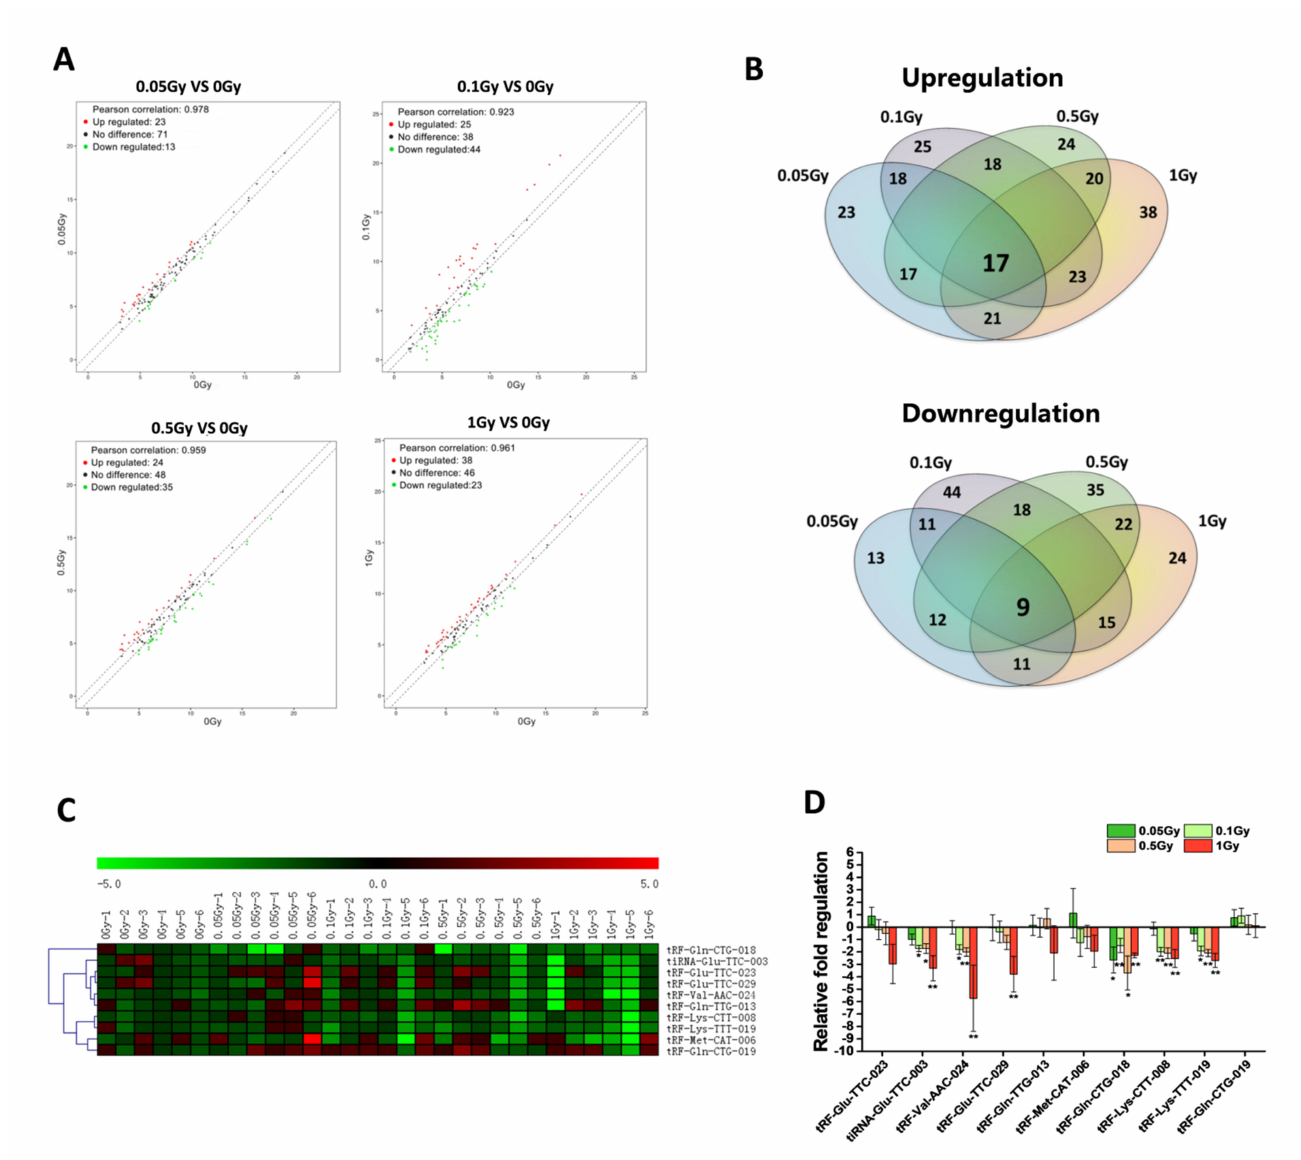
Figure 2. Screening and validation of differentially expressed serum tsRNAs after carbon ion irradiation. ( A ) The scatter plots showing the relative expression of serum tsRNAs in mice of exposure to 0.05, 0.1, 0.5, and 1 Gy of carbon ions (the red dots above the top line or the green dots below the bottom line indicate more than 1.5 times fold change between the two compared groups). ( B ) Venn diagram showing the differentially expressed tsRNAs in different dose groups. ( C ) The relative expression changes of the 10 selected tsRNAs were validated by RT-qPCR and the results are shown by hierarchical clustering heat map (red indicates upregulation and green indicates downregulation). ( D ) The fold regulation of the 10 selected tsRNAs in response to different doses of carbon ion irradiation. * p < 0.05, ** p < 0.01, compared with control group (0